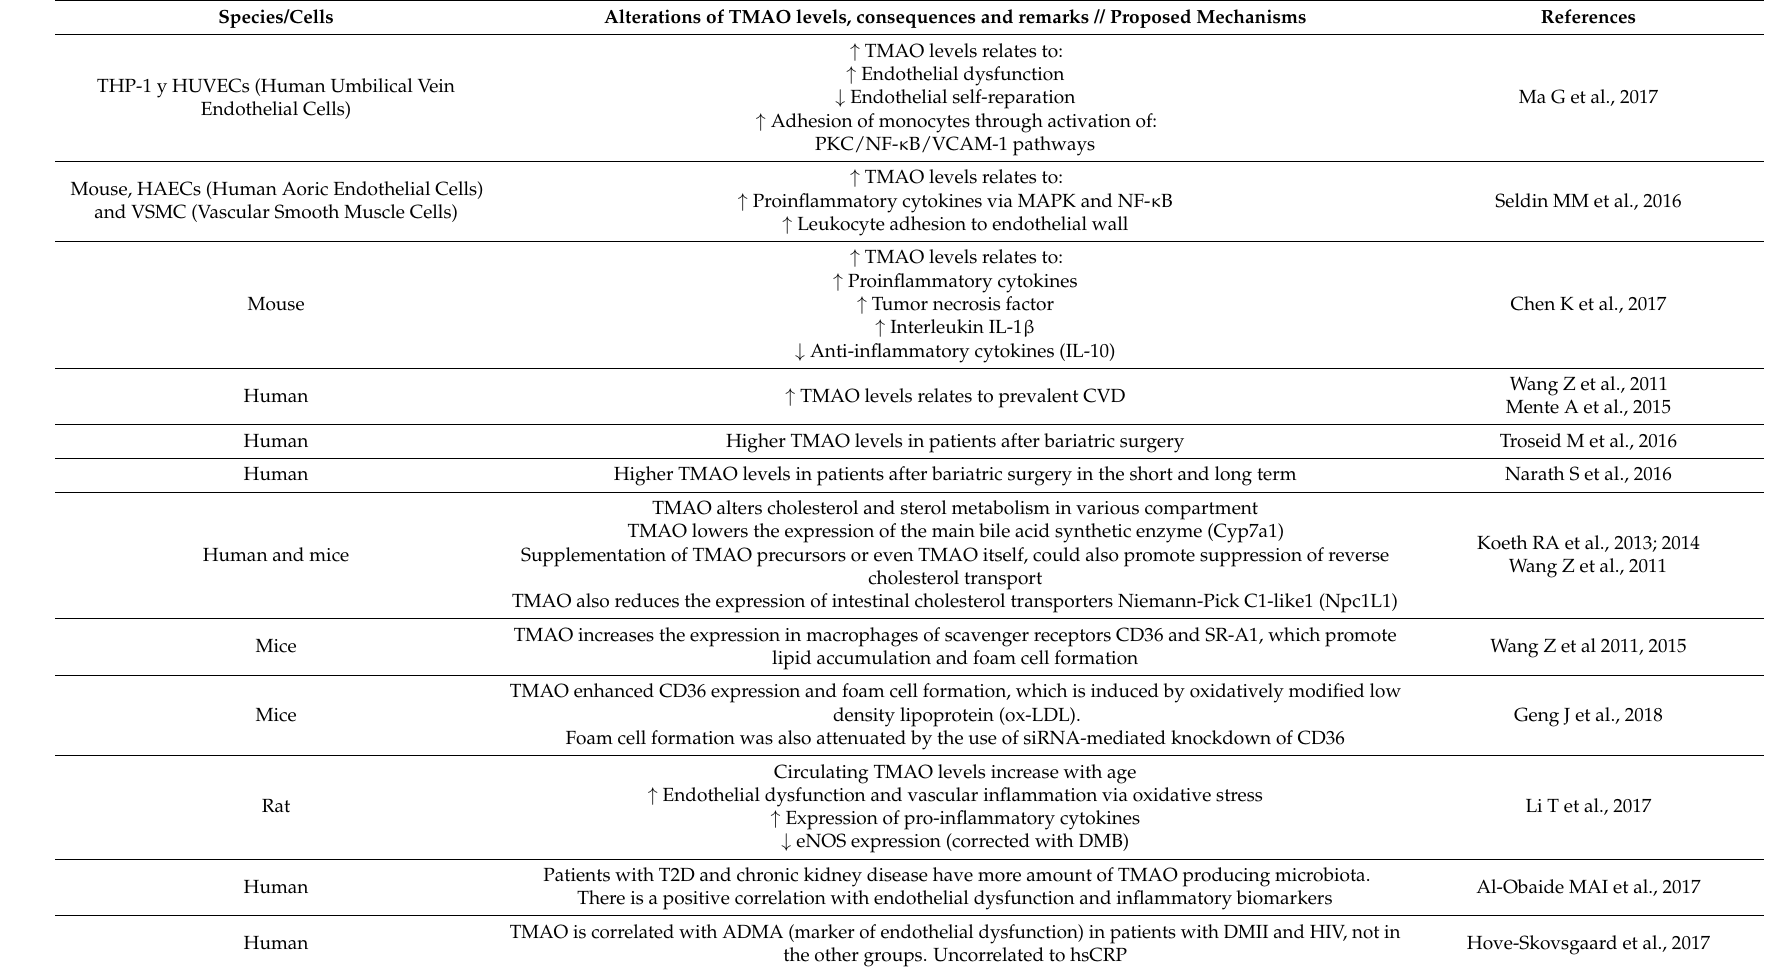
Table 2. Relationships between atherosclerosis, cardiovascular disease and TMAO in different experimental models.